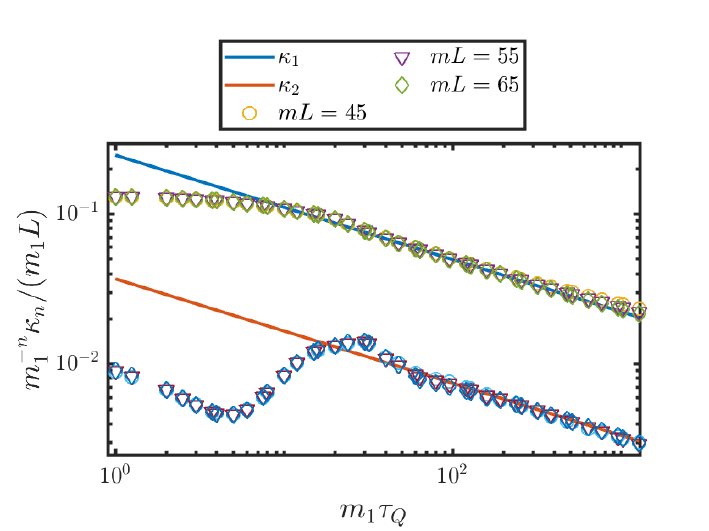
Figure 5.3: The first two cumulant densities for linear ramps crossing the QCP along the E integrable line: the symbols represent cutoff-extrapolated TCSA data while 8 the solid lines show the expected KZ scaling ∼ τ